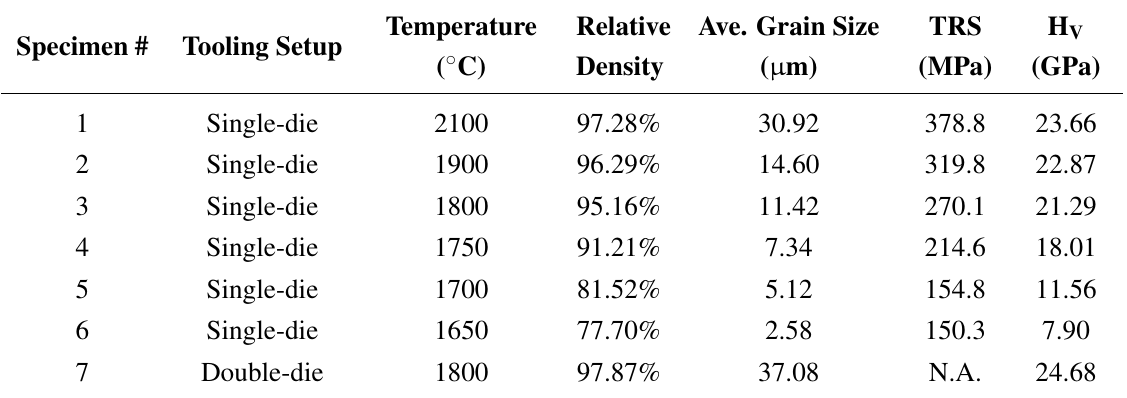
Table 4. Transverse rupture strength and microhardness test